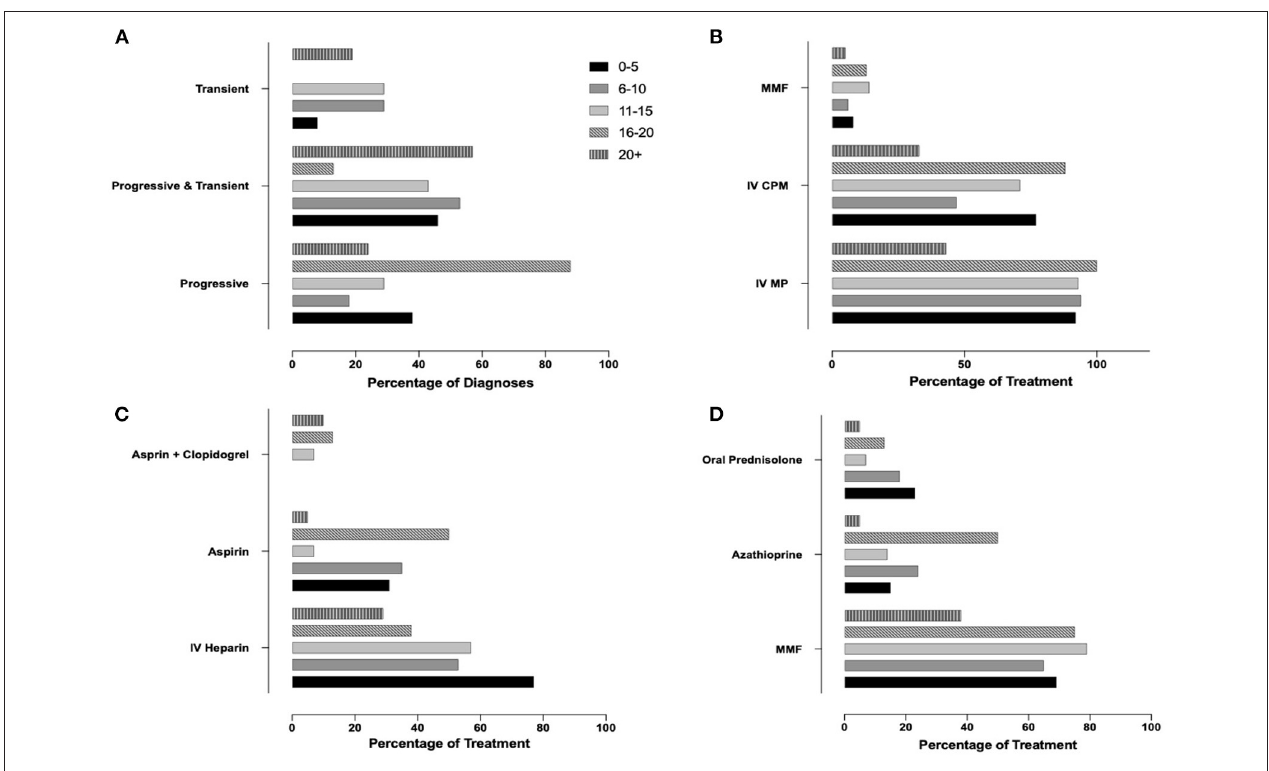
FIGURE 4 | Influence of Experience in Approach to Diagnosis and Treatment in case 1. (A) Correlation between number of years of experience clinicians had and their diagnosis of the patient in case 1. (B) Years of experiences vs. Induction treatment. (C) Years of experience vs. Acute anticoagulation treatment. (D) Years of experience vs. Maintenance